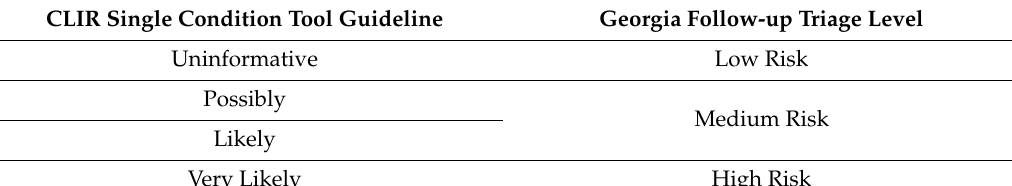
Table 1. Correlation between Collaborative Laboratory Integrated Reports (CLIR) single condition tool guidelines and Georgia newborn screening (NBS) follow-up triage risk levels.